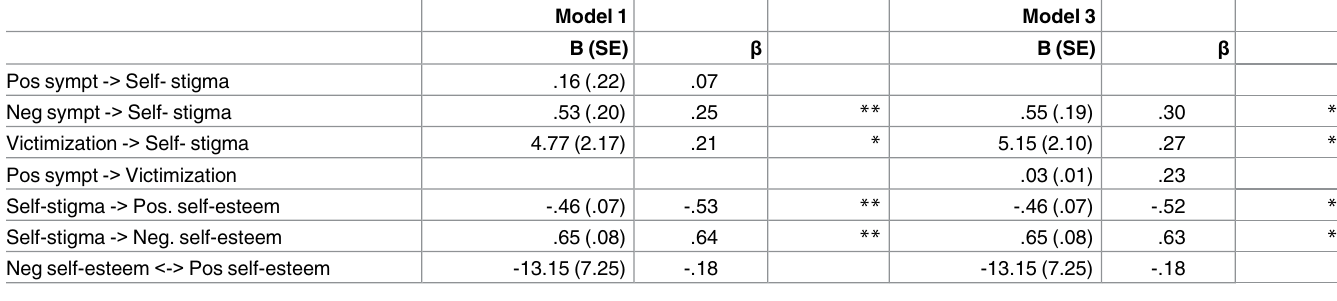
Table 2. (Standardized) effects in in the original hypothesized model (Model 1) and in the new model (Model 3).